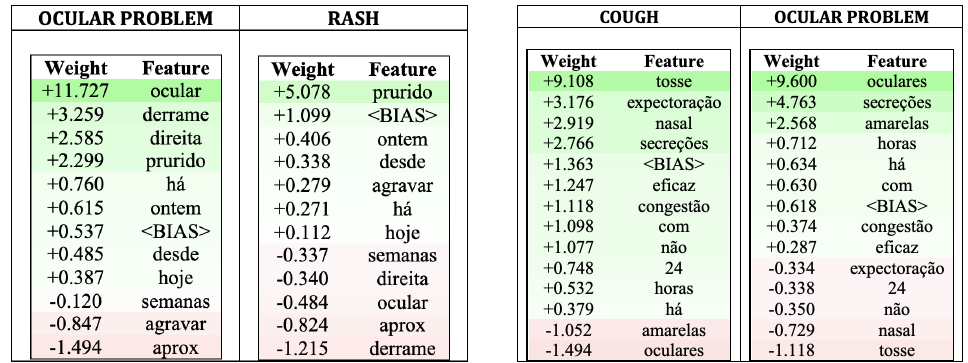
Figure 11. ELI5 output for two “Ocular problem” pathway examples: the left example was classified as “Ocular problem”; the right example was classified as